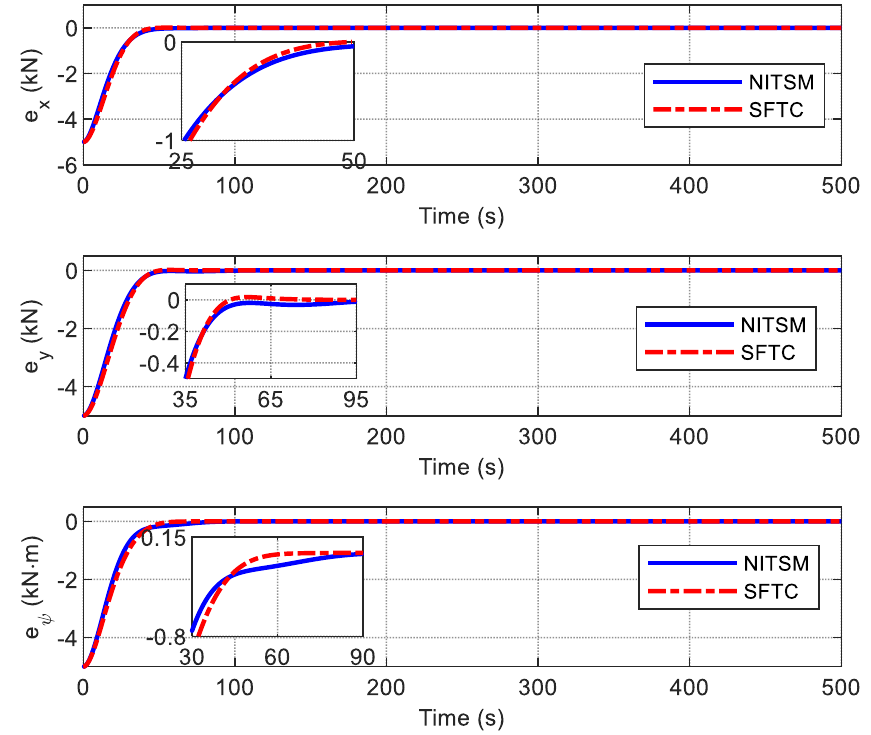
Figure 9. Comparison of tracking errors.